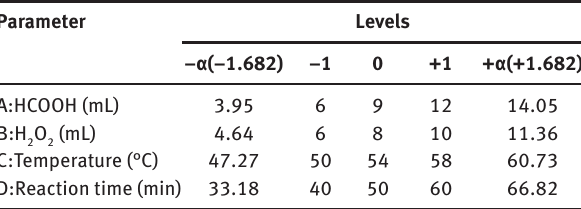
Table 1: The levels of factors for the central composite design